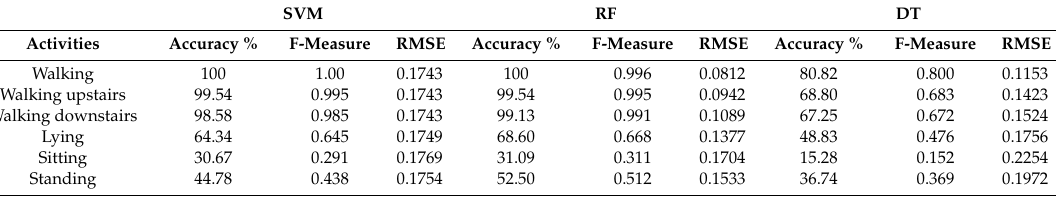
Figure 3. Comparison of user recognition accuracies achieved by RF classifier on the HAR dataset with and without feature selection. Table 2. Results of user recognition based on performance metrics for selected activities in the HAR